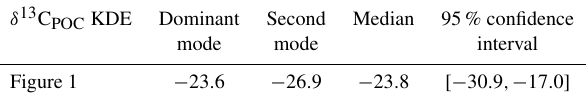
Table A1. Statistical properties of the KDE derived for Fig. 1 eval- uated on an equidistant grid over [− 55 . 15 , − 4 . 5 ] with 1001 grid points: the first column indicates the respective KDE, the following two its modes, the fourth the median and the fifth the 95% confi- dence interval of the respective KDE. All values are given in per mill.